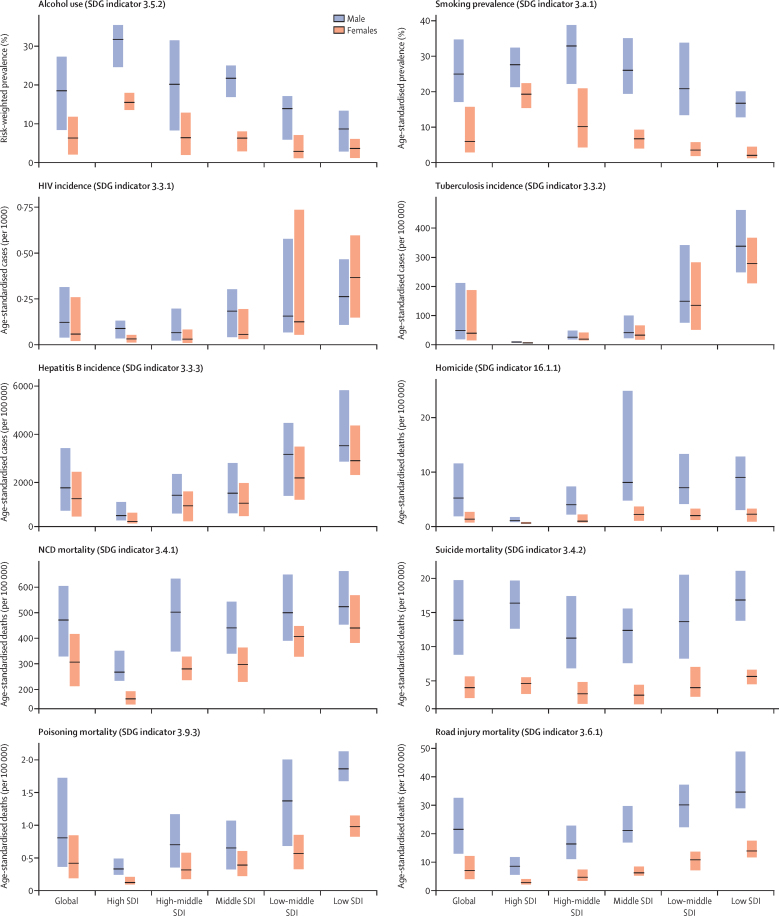
Median values for select SDG indicators, by sex, at the global level and by SDI quintile, 2017The lengths of the coloured rectangles represent the IQRs. More detail on the SDG indicators included in this figure can be found in table 1. SDG=Sustainable Development Goal. SDI=Socio-demographic Index.